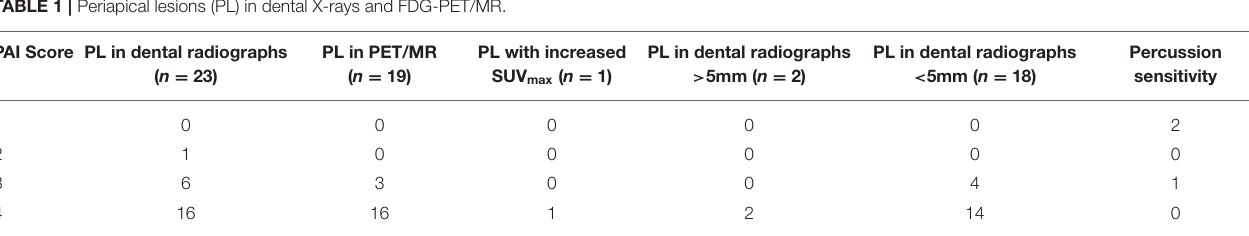
PL in dental radiographs < 5mm ( n = 18)